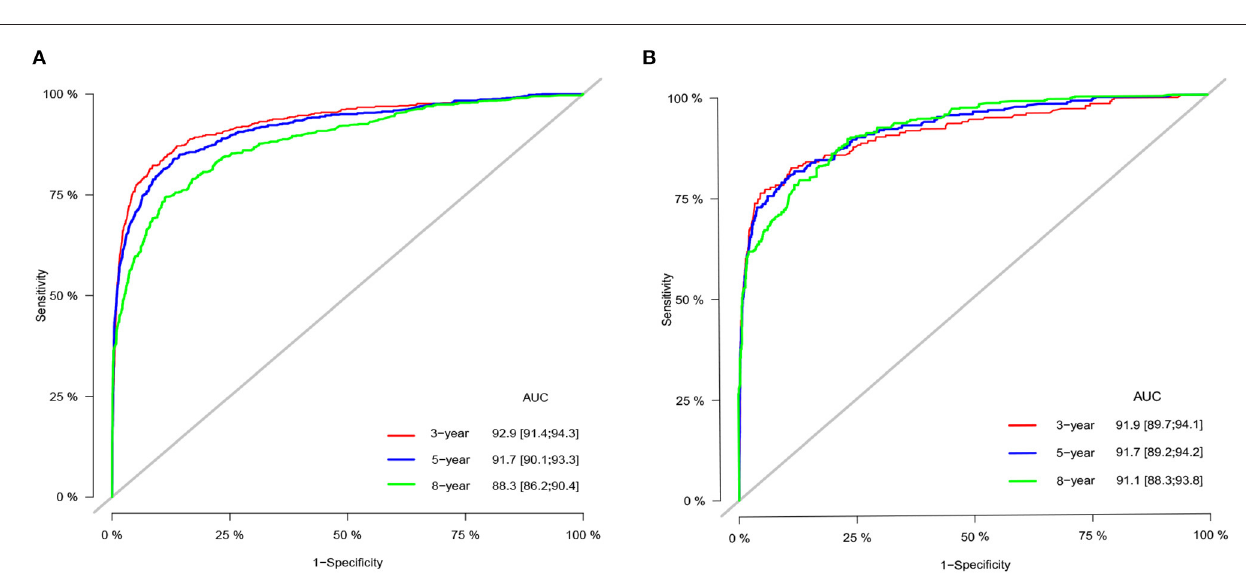
compared with non-therapeutic randomized clinical